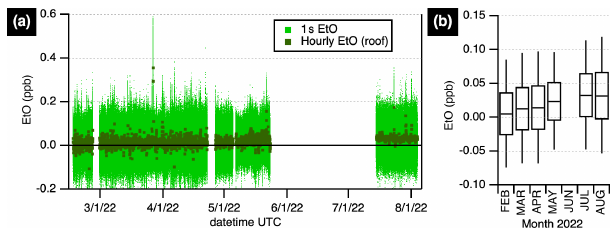
Figure 3. Ambient ethylene oxide at a site in Billerica, Mas- sachusetts, United States. (a) Data at 1s (pale green) are shown alongside hourly averages (dark green squares). (b) Monthly box- plot showing the median and 25th and 75th quartiles, with whiskers extending to the 5th and 95th percentiles. Data prior to June 2022 were acquired from a rooftop inlet with humidity-matched auto- backgrounds every 30min; data after July 2022 were acquired from a 3m inlet with humidity-matched autobackgrounds every 2min. Gaps in the time series are due to laboratory or field experiments.